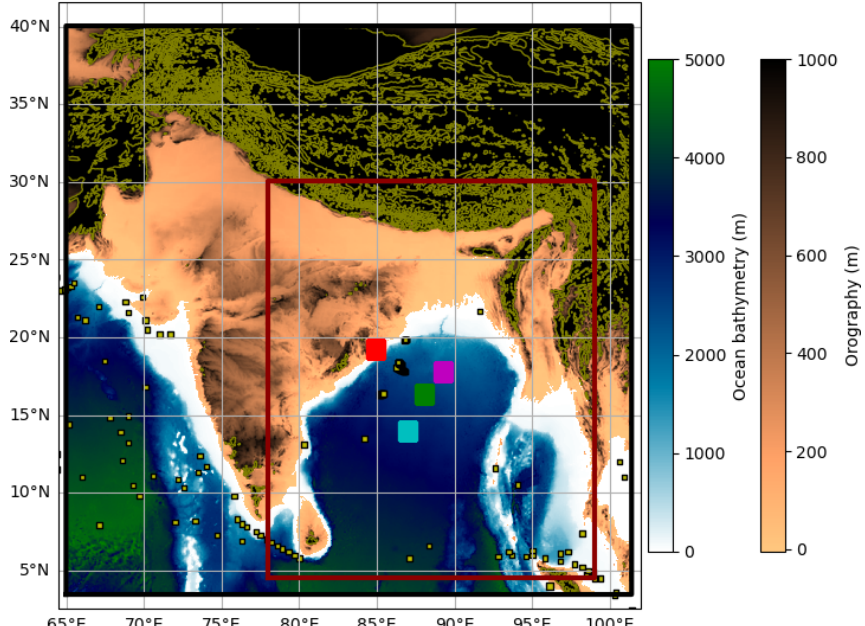
Figure 1. Illustration of RCS-IND1 domain coupled system domain extent. Shaded contours represent the atmosphere model orography over land and ocean model bathymetry respectively. Orography contours for land higher than 1000m (black shading) are marked every 1000m. The region highlighted by the maroon box shows the region of focus for results presented in this paper. Marked locations indicate in situ observation points referred to in the results section: from north to south, red shows Gopalpur (84.9 ◦ E, 19.3 ◦ N), magenta shows 23091 (89.2 ◦ E, 17.8 ◦ N), green shows 23093 (88.0 ◦ E, 16.3 ◦ N), and blue shows 23459 (87.0 ◦ E, 14.0 ◦